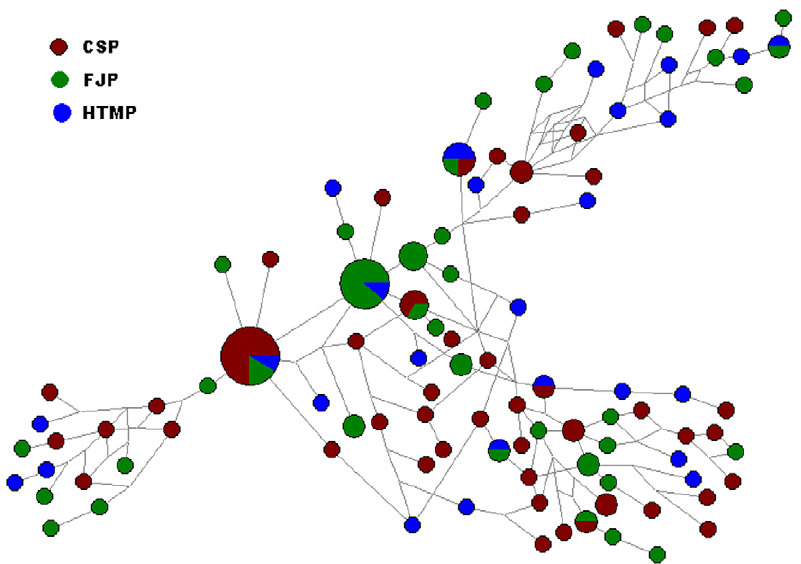
Figure 7. STR network of haplogroups O3*, O3e* and O3e1 of the three EC high-risk populations. In the network, HTMP have more STR haplogroup polymorphisms than CSP and FJP. Six Y-STRs of HTMP are share by CSP and/or FJP. Circles represent lineages, area is proportional to frequency, and color indicates population of origin.